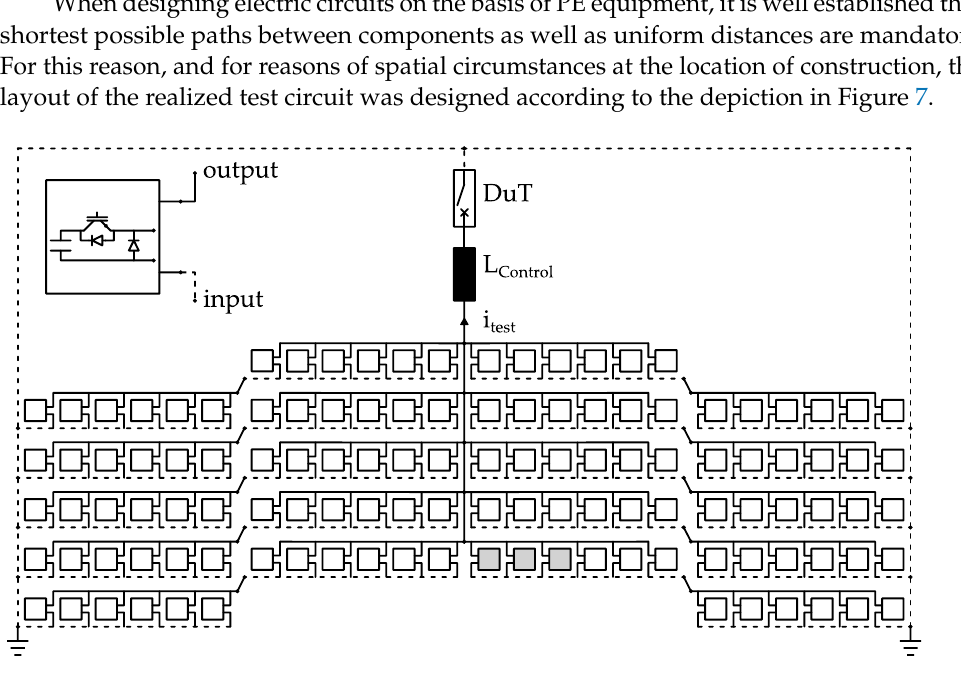
Figure 7. Schematic visualization of the interconnection of, in total, 120 individual PEBC modules in demonstrator high-power test circuit. The three PEBC modules used for the experiments’ measurements are indicated as greyed PEBC modules.